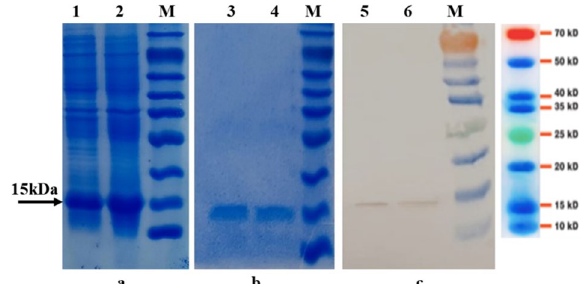
Figure 1. Analysis of protein expression: IPTG Induced bacterial lysate ( a ), Purified Protein ( b ) and western blotting analysis ( c ). #1, 3, 5: wtIL-2; #2, 4, 6: Mutant IL-2; M: Protein molecular weight marker. The mutant IL-2 protein was made by three amino acid substitutions (K35A, E61A, and F42A). The full-size original gels and the blot are presented in Supplementary Fig. S1a, S1b and S1c,